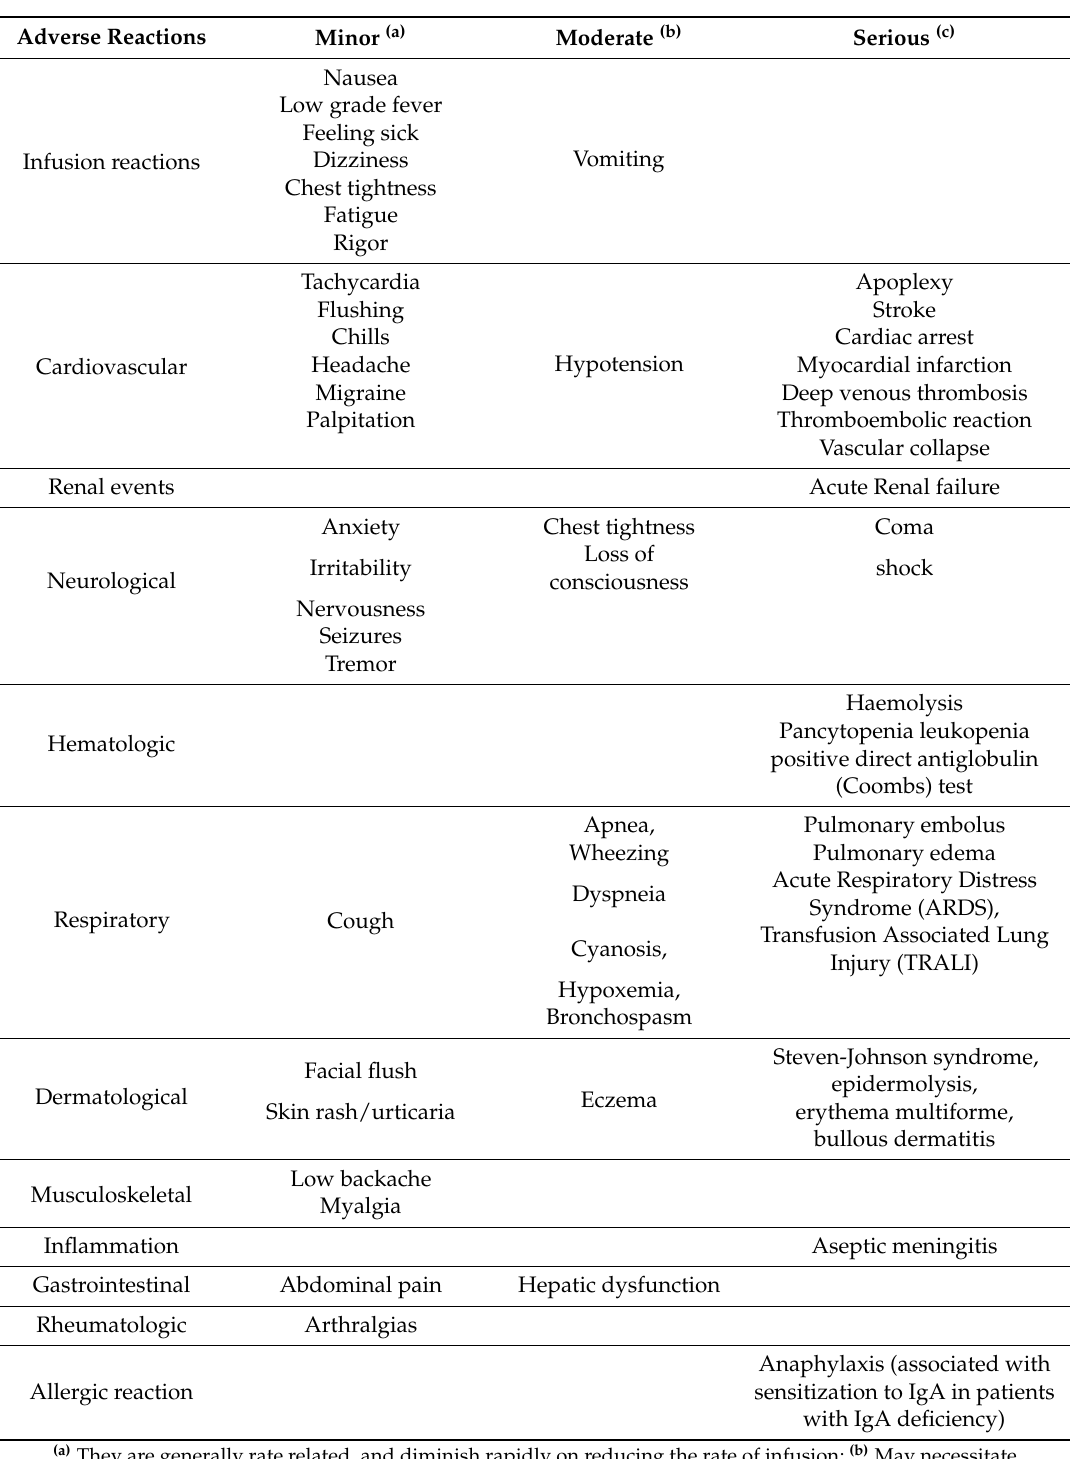
Table 3. Adverse reactions to